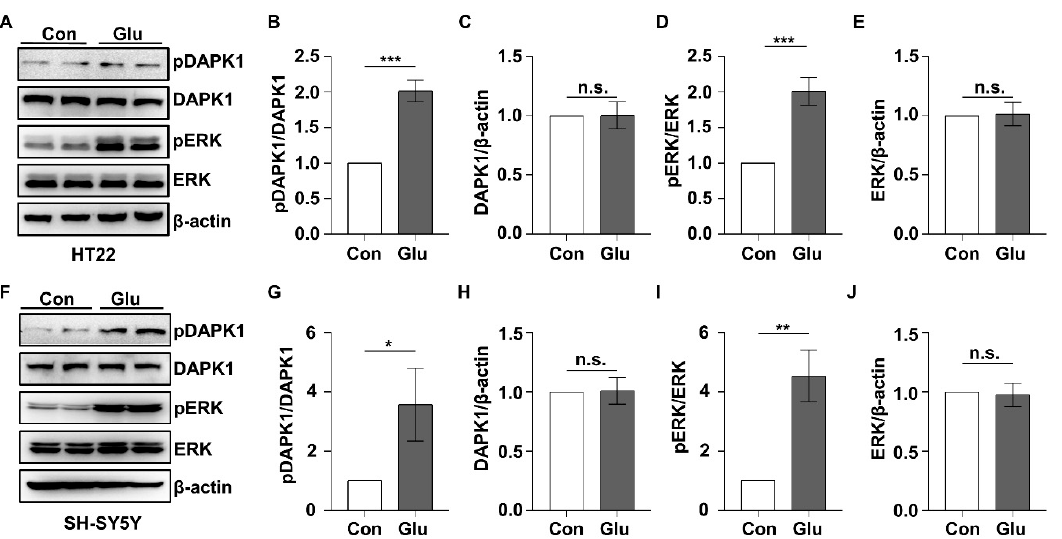
Figure 5. DAPK1 is activated after glutamate exposure. HT22 and SH-SY5Y cells were treated with glutamate (10 mM), and cells were harvested 30 min after glutamate administration. ( A – J ) HT22 or SH-SY5Y cell lysates were resolved on SDS-PAGE gels and then subjected to immunoblotting assays using anti-pSer735-DAPK1, anti-DAPK1, anti-pThr202/Tyr204 ERK, anti-ERK, or anti- β -actin antibodies (* p < 0.05, ** p < 0.01, *** p < 0.001 vs. the control; two-tailed Student’s t -test). n.s., not significant ( p > 0.05). All data represent the mean ± SD of three independent experiments.